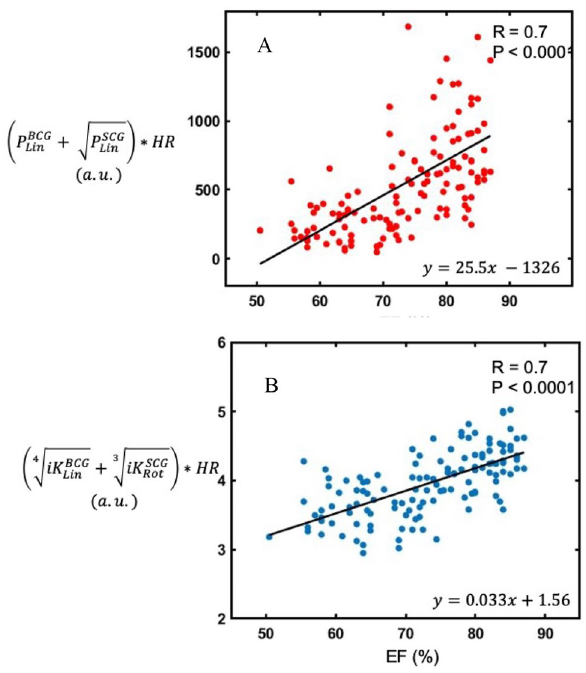
Figure 2. Correlations between metrics of BCG and SCG with the LVEF. Mathematical models combining: ( A ) linear P Max of SCG and BCG with the LVEF and ( B ) i K of SCG and BCG with the LVEF (both R = 0.7, p <